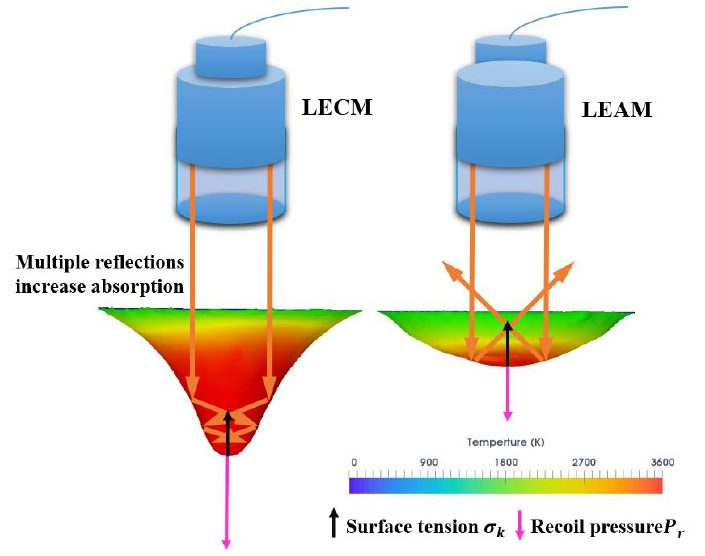
Figure 10. Diagram of temperature distribution and laser reflection path in the keyhole of different modes.